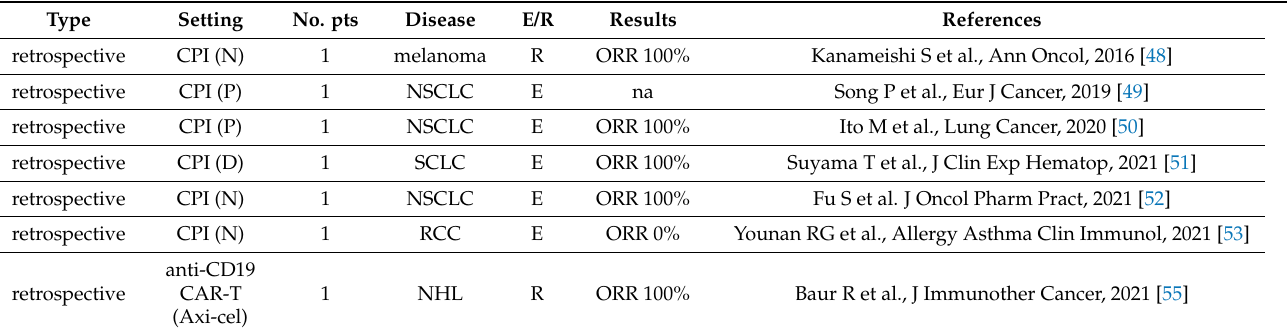
Table 3. Studies on TPO-RA after immune checkpoint inhibitors therapy and CAR-T